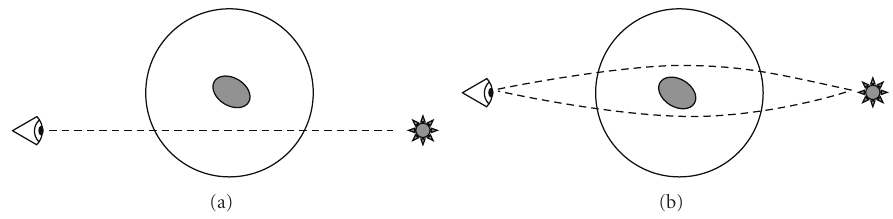
Figure 1: Weak and strong lensing. (a) Weak lensing occurs when the lens (here illustrated by a gray elliptical galaxy, surrounded by a dark matter halo which extends to the outer circle) lies relatively far from the line of sight between the observer (eye) and the background light source (star). In this case, where the sightline misses the central galaxy, only a single image is produced, subject to mild magnification and distortion. The signatures of this are only detectable in a statistical sense, by studying the weak lensing e ff ects on large numbers of background light sources. (b) Strong lensing can occur when the dense central region of the lens galaxy is well-aligned with the line of sight. The light from the background light source may then reach the observer along di ff erent paths, corresponding to separate images in the sky. This case is also associated with high magnifications and strong image distortions. The angular deflection in this figure, as in all subsequent ones, has been greatly exaggerated for clarity.